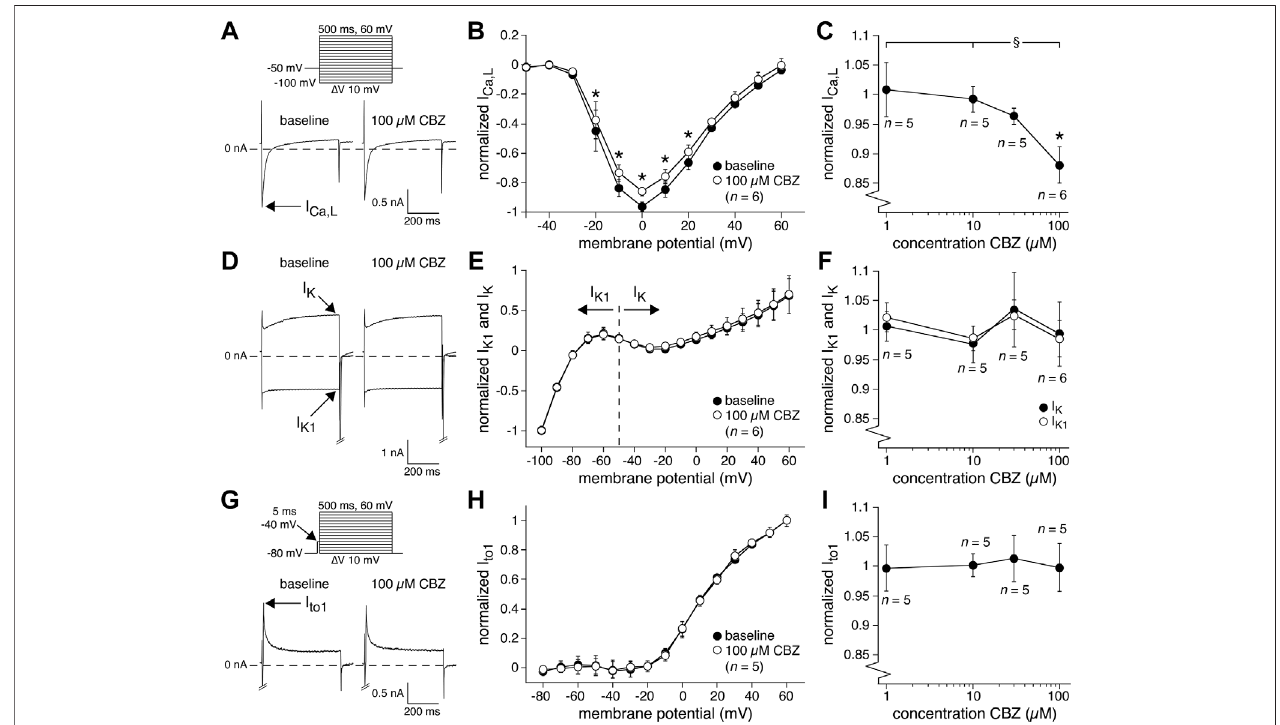
FIGURE4| Carbamazepine(CBZ)reducestheL-type Ca 2+ currentofrabbit ventricular cardiomyocyteswithoutaffecting K + currents. (A) Typicalrecordingsofthe L-type Ca 2+ current (I Ca,L ) at 0 mV under baseline conditions and in presence of 100 µM CBZ. Inset: voltage clamp protocol used. Cycle length was 2 s. (B) Average I-V relationship of I Ca,L under baseline conditions and in presence of 100 µM CBZ. I Ca,L was normalized to the maximal peak amplitude under baseline conditions, but peak currentwassetto − 1toretainthewell-knowninwarddirectionofI Ca,L .* p < 0.05CBZversusbaseline(Two-WayRMANOVA). (C) Concentrationdependencyofthe CBZ effect on I Ca,L amplitude measured at 0 mV. * p < 0.05 CBZ versusbaseline(One-Way RM ANOVA); § p < 0.05 CBZ 100 µM versus lower concentrations(One-Way ANOVA). (D) Typical recordings of the delayed recti fi er K + current (I K ; at +60 mV) and inward recti fi er K + current (I K1 ; at − 100 mV) under baseline conditions and in presence of 100 µM CBZ. Voltage clamp protocol as in panel (A). (E) Average I-V relationships of I K and I K1 under baseline conditions and in presence of 100 µM CBZ. Thecurrentswerenormalizedtothecurrentmeasuredat − 100 mV(andsetto − 1)underbaselineconditions. (F) ConcentrationdependencyoftheCBZeffectonI K1 and I K amplitudemeasuredat − 100 mVand+60 mV,respectively. (G) TypicalrecordingsofthetransientoutwardK + current(I to1 )at+60 mVunderbaselineconditionsandin presence of 100 µM CBZ. Inset: voltage clamp protocol used. Cycle length was 5 s. (H) Average I-V relationships of I to1 under baseline conditions and in presence of 100 µM CBZ. I to1 was normalized to the current at +60 mV under baseline conditions. (I) Concentration dependency of the CBZ effect on I to1 amplitude at +60